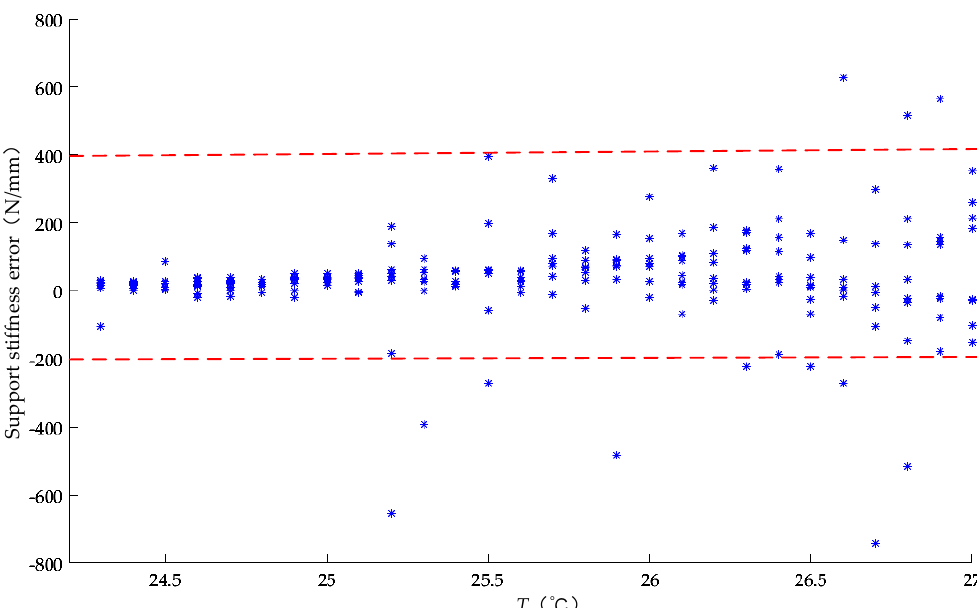
Figure 13. Support stiffness error with hydraulic oil with unfiltered air.